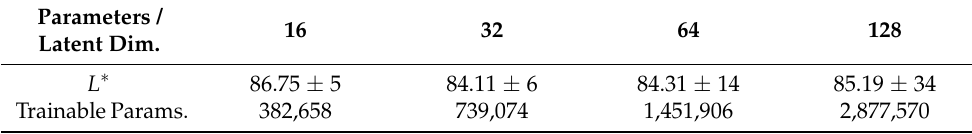
Table 5. MAML 2 nd 1–shot experiments, average L ∗ and trainable parameters with varying latent dimension. The L ∗ values are obtained over the last 300 episodes of test tasks T v evaluation. The results are provided with 95% confidence intervals, averaged over 3 repetitions.